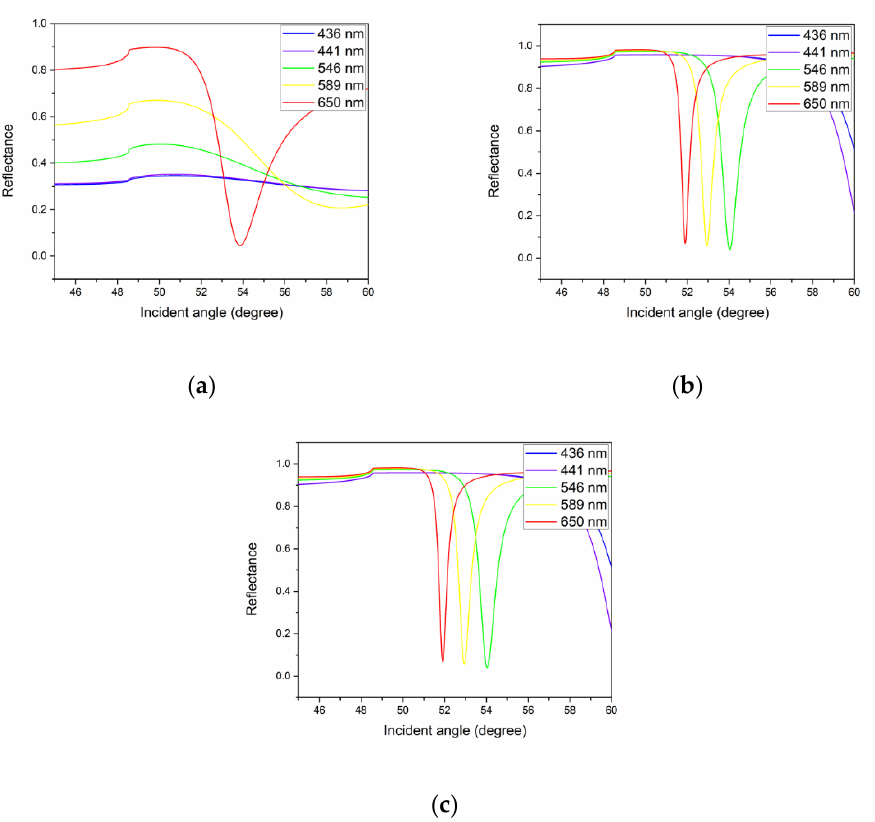
Figure 5. SPR signal using different excitation wavelength for ( a ) copper, ( b ) gold, and ( c ) silver (thickness of 50 nm) in contact with water.